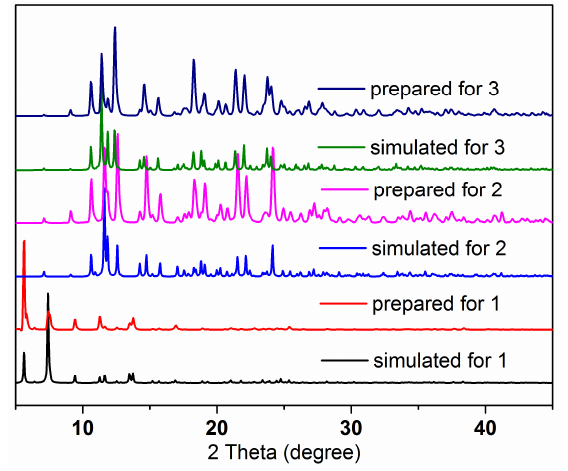
Figure 4. PXRD curves for 1 – 3 .